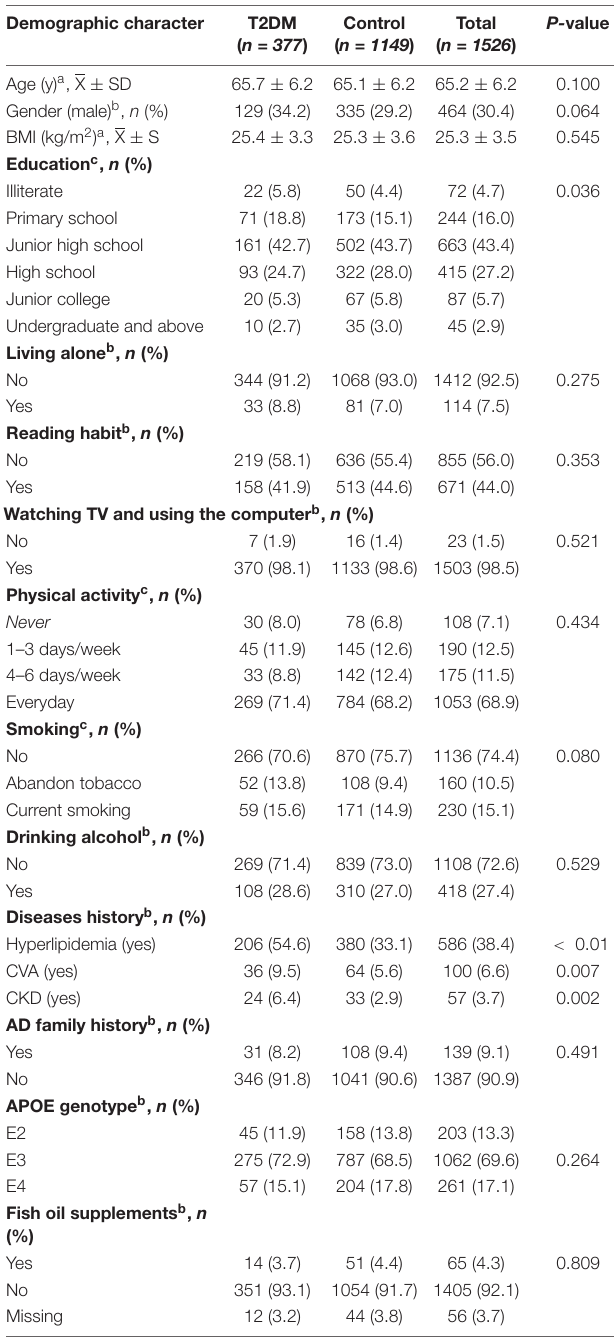
TABLE 1 | Demographic characteristic of the